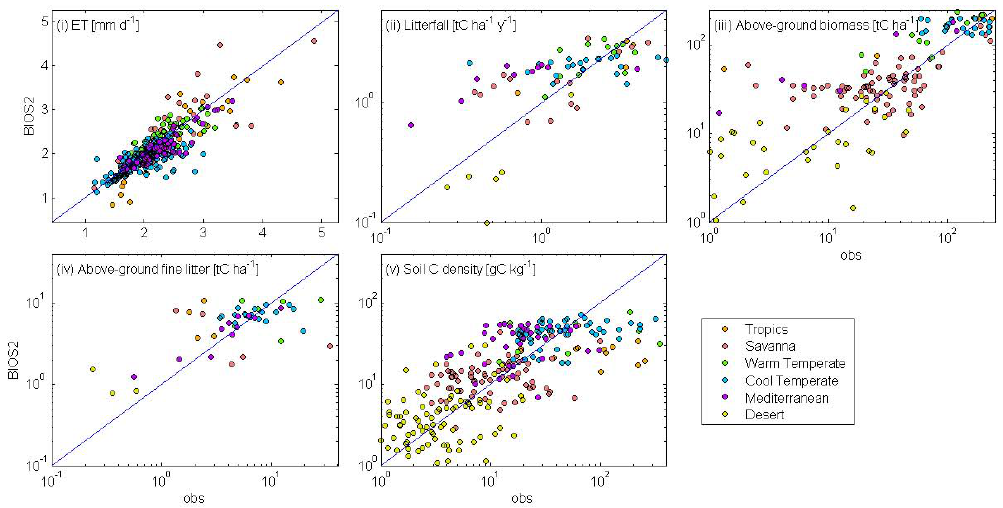
Fig. 9. Scatter plots of long-term model predictions vs observations of (i) catchment-scale ET derived from streamflow; (ii) leaf-NPP (litter- fall); (iii) above ground biomass; (iv) above ground fine litter; and (v) soil carbon density in the top